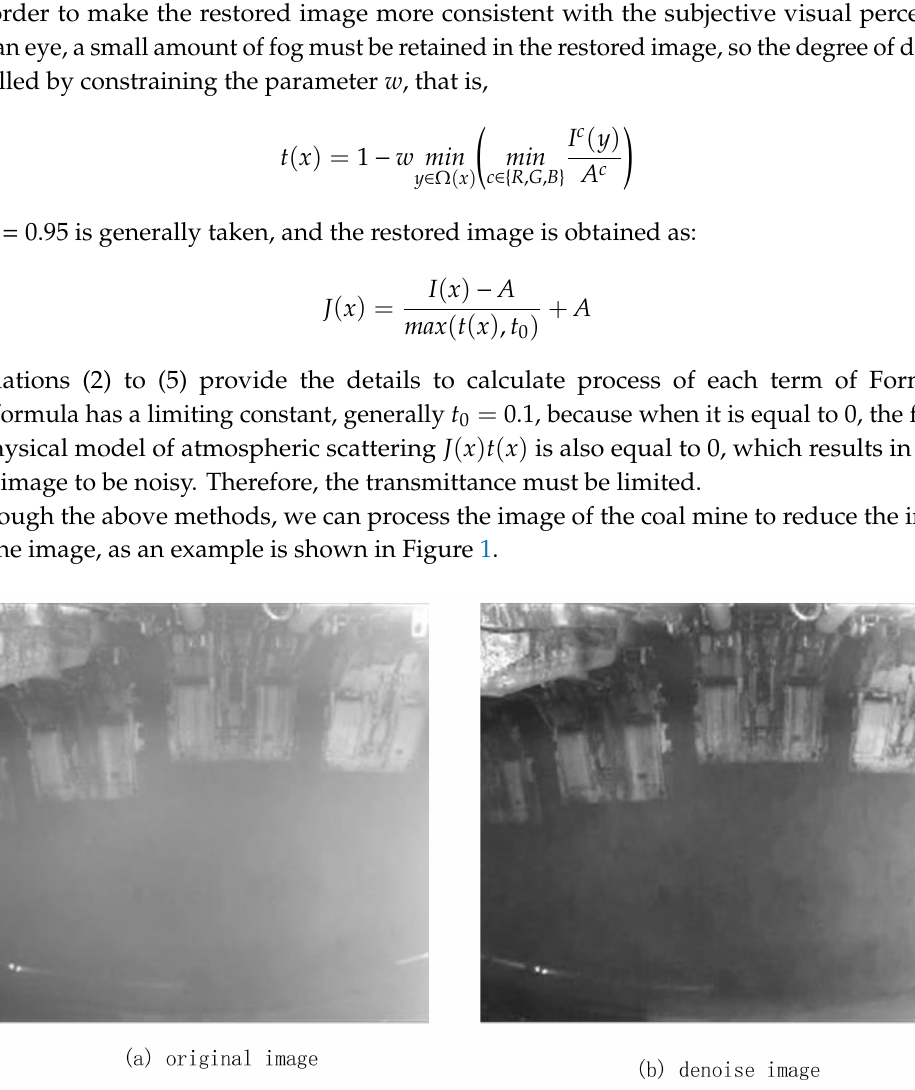
Figure 1. An example of image defogging: original image ( a ) and denoised (defogged) image ( b